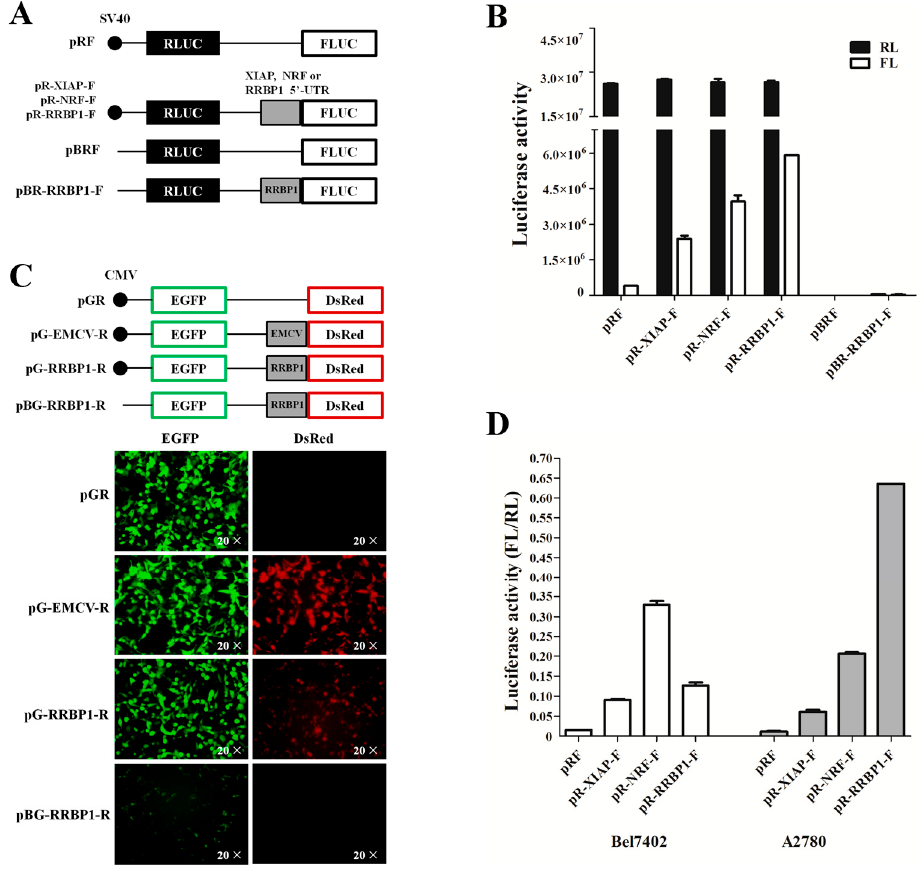
Figure 2. Analysis of internal ribosome entry site (IRES) activity of the RRBP1 5 ′ UTR sequence. ( A ) Dual-luciferase reporter vector construction. Positive IRES activity sequence, X-linked inhibitor of apoptosis protein (XIAP) and NF- κ B repressing factor (NRF), and detected RRBP1 5 ′ UTR sequences were inserted between Renilla and firefly luciferase in plasmid pRF with or without promoter simian virus (SV40); ( B ) both luciferase activities were determined following transfection in human embryonic kidney 293 (HEK293) cells; ( C ) dual-fluorescent protein reporter vector construction. Positive viral IRES activity sequence, encephalomyocarditis virus (EMCV), and detected RRBP1 5 ′ UTR sequence were inserted between red and green fluorescent protein genes with or without promoter cytomegalovirus (CMV). The indicated plasmid was then transfected into HEK293 cells and the expression efficiency of the reporter genes were analyzed by fluorescence microscopy; ( D ) dual-luciferase reporter vector was transfected into Bel7402 and A2780 cell lines and luciferase activities from each cell line was measured, respectively. The ratio of firefly luciferase (FL) to renilla luciferase (RL) represented IRES activity of the inserted 5 ′ UTR. The expression data are presented as the mean ± SEM (standard error of the mean) of triplicate samples.